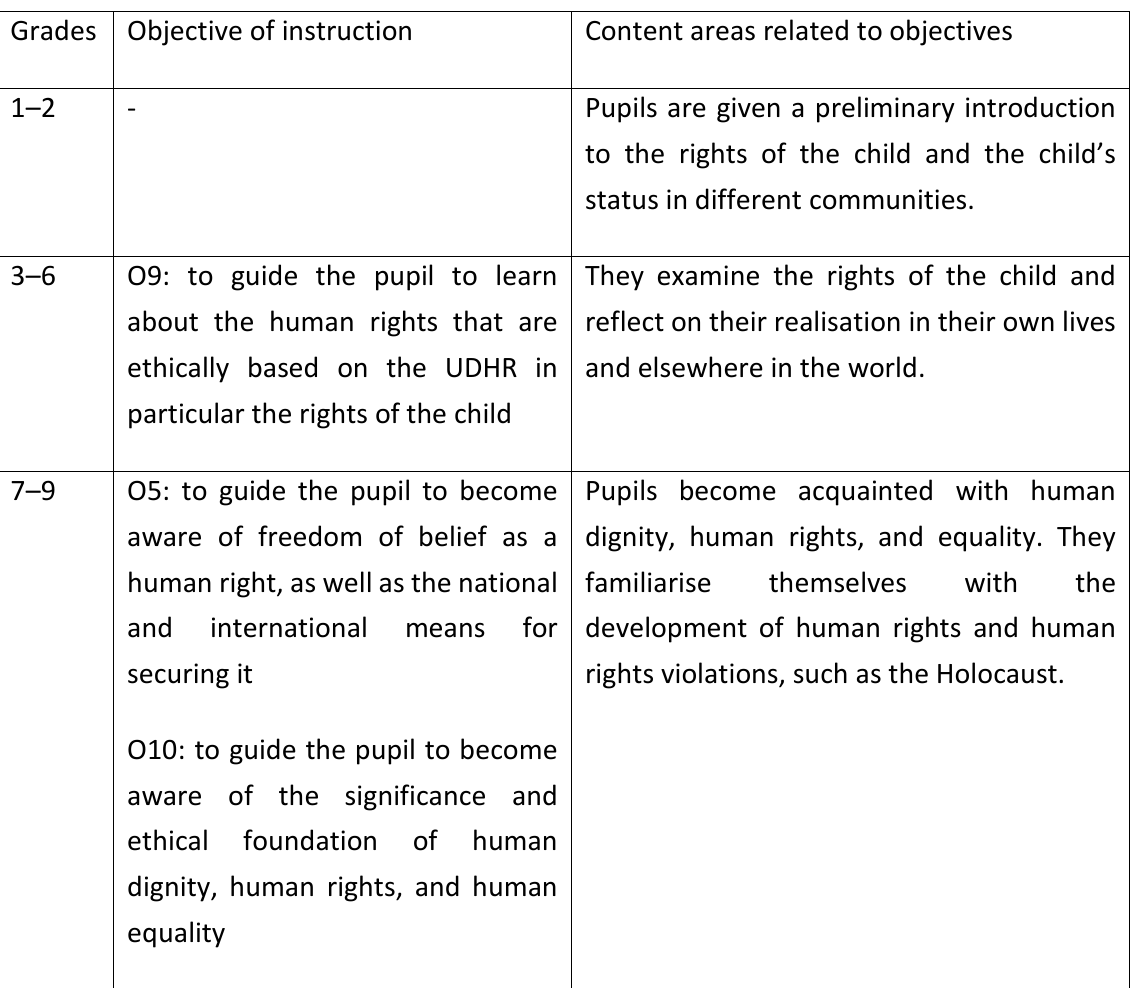
Table 2: Human rights as objectives of instruction and explicit content areas in the culture, worldview and ethics